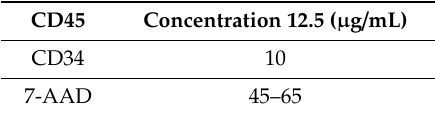
Table 1. Concentration of antibodies for flow cytometry.